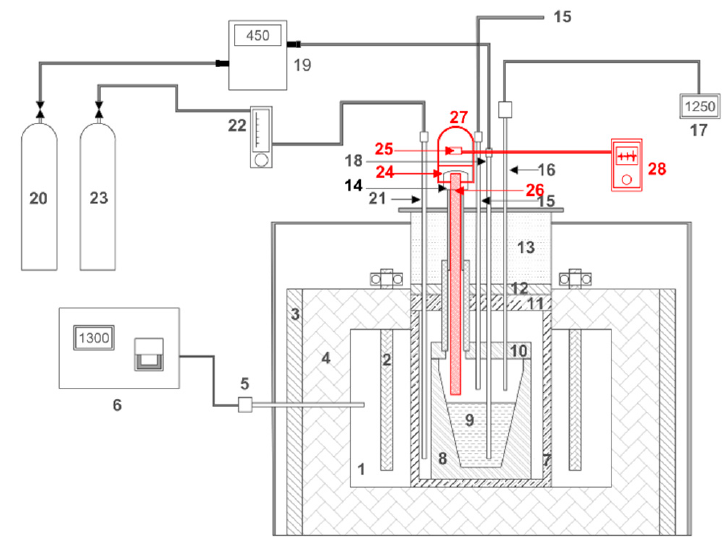
Figure 1. Experimental system for the conversion experiments. 1. Reaction chamber. 2. SiC resistors. 3. Thermal insulation. 4. Refractory bricks. 5. Control type S thermocouple. 6. Controller. 7. Security crucible. 8. Working crucible. 9. Molten bath. 10. Working cover. 11. Safety cover. 12. Thermal insu- lation. 13. Furnace cover. 14. White metal feeding. 15. Gas outlet line. 16. Thermocouple. 17. Tem-